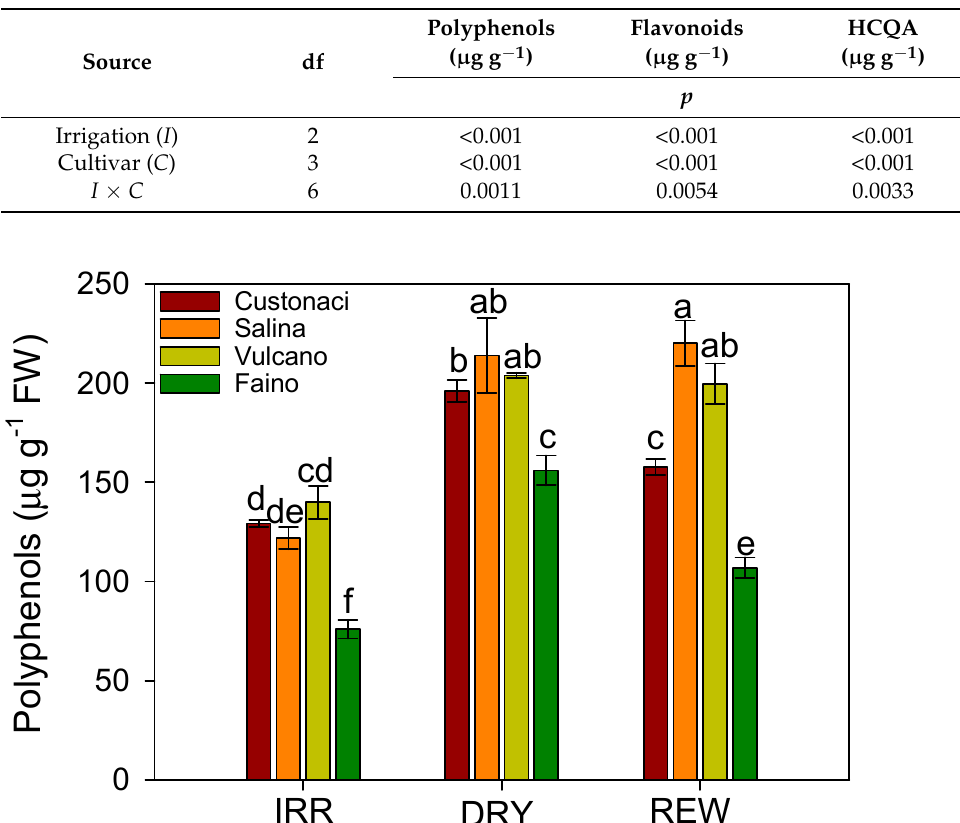
e Figure 4. Flavonoids content in fruits of four cultivars of tomato in response to irrigation (IRR: full irriga- tion; DRY: no irrigation; REW: rewatering). Bars are mean value ± standard error ( n = 3). Different letters among cultivars across irrigation treatments indicate significance at p ≤ 0.05 by Tukey’s test.